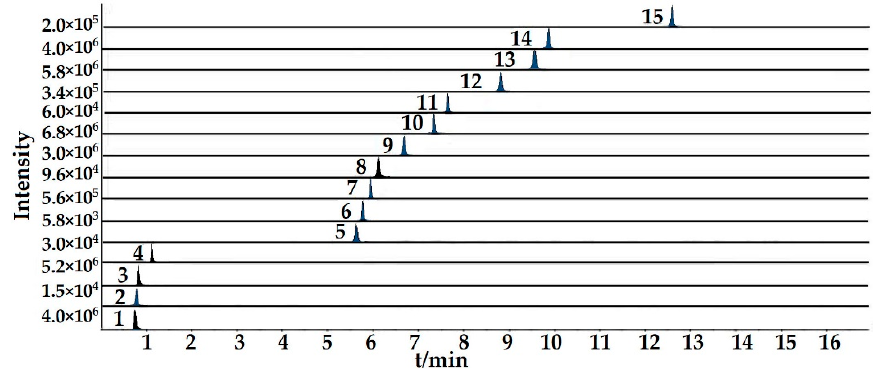
Figure 1. Representative extract ion chromatograms (XIC) of MRM chromatograms of 15 investigated compounds.